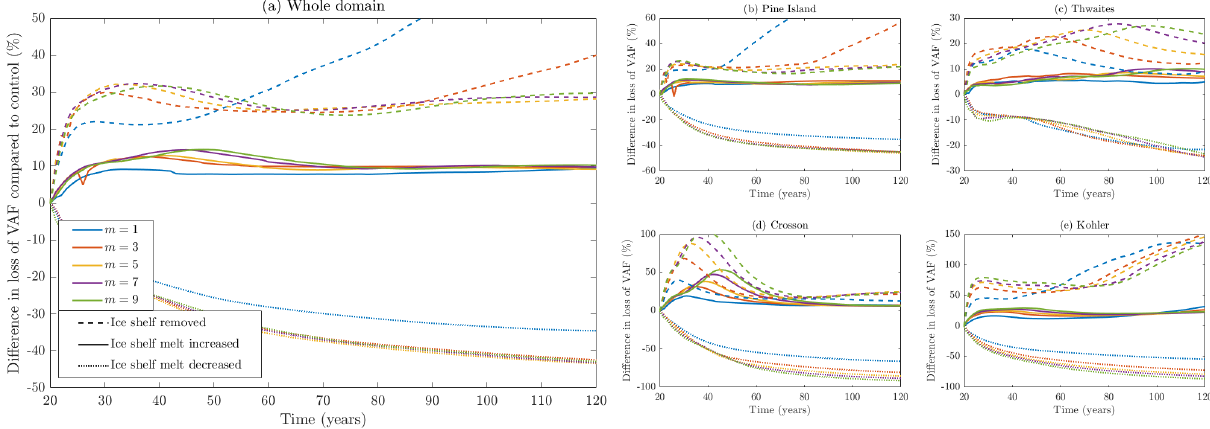
Figure 8. Additional VAF loss compared to the control branch for the Tsai sliding law with µ k = 0 . 5 and different values of m , showing the contributions of (a) the entire ASE domain and (b–e) each region within the domain. Note that the y axes for each region use different